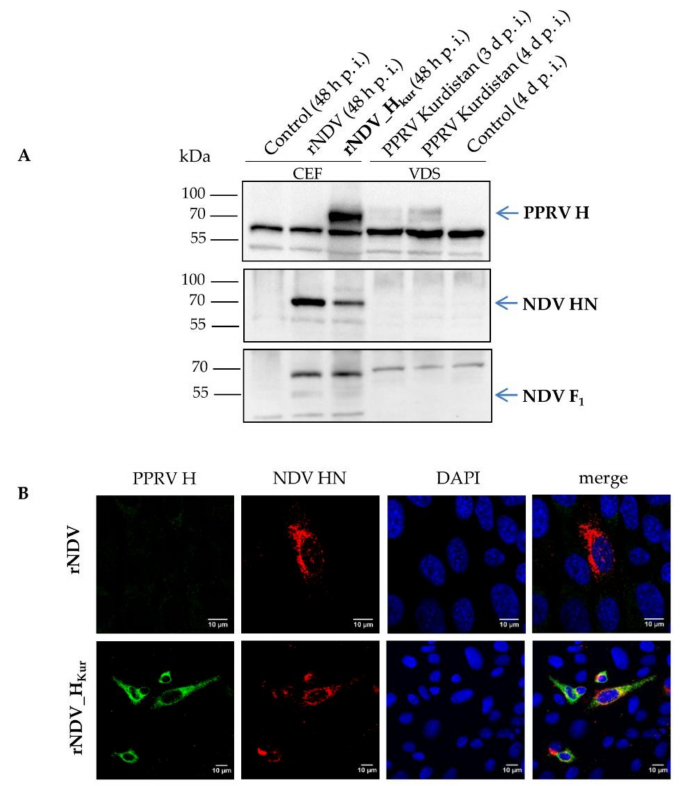
Figure 2. In vitro analyses of PPRV H expression. ( A ) Chicken embryo fibroblasts (CEFs) were infected with rNDV or rNDV_H Kur (multiplicity of infection (moi) 5) and harvested 48 h post infection (p.i.). Vero dog SLAM cells (VDS) were infected with PPRV Kurdistan / 11 (moi 1) and harvested 3 or 4 days p.i. The cell lysates were subjected to SDS-PAGE and subsequently to Western blot analysis. Viral proteins were visualized by immunostaining with rabbit antisera against PPRV-H, NDV-HN, and NDV-F. Binding of primary antibodies was detected after incubation with peroxidase-conjugated species-specific secondary antibodies by chemiluminescence substrate (Thermo Scientific). Identified proteins are indicated on the right. The molecular weights of marker proteins (PAGE Ruler ™ Prestained Protein Ladder (Thermo Scientific)) are indicated on the left. ( B ) Quail muscle cells (QM9) were infected with rNDV or rNDV_H Kur (moi 0.1), fixed 24 h p.i. and immunostained with monoclonal mouse antibodies against NDV-HN (red) and a rabbit antiserum against PPRV-H (green). Nuclei appear blue by 4 (cid:48) ,6-diamidino-2-phenylindole (DAPI) staining. After Alexa 568 α -mouse and 488 α -rabbit secondary antibody (Invitrogen) incubation, viral protein expression and cellular distribution were analyzed by confocal